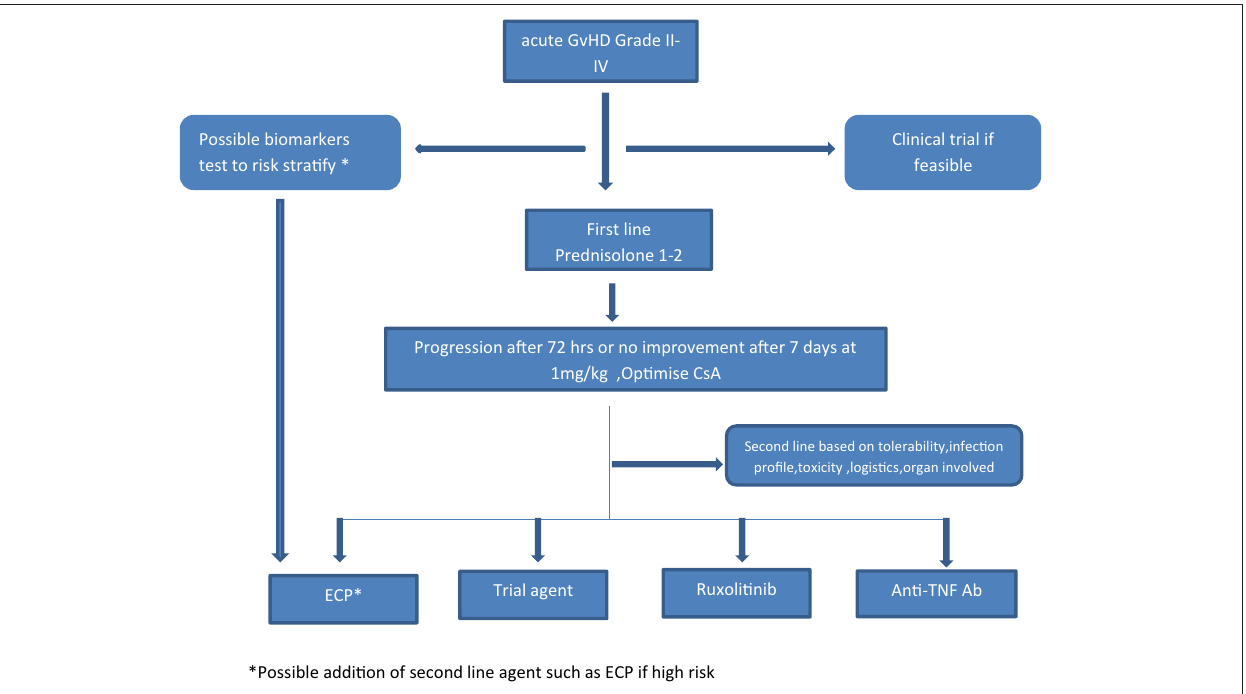
FIGURE 2 | Proposed algorithm for incorporating ECP in the management of aGvHD. *Possible addition of second line agent such as ECP if high risk.